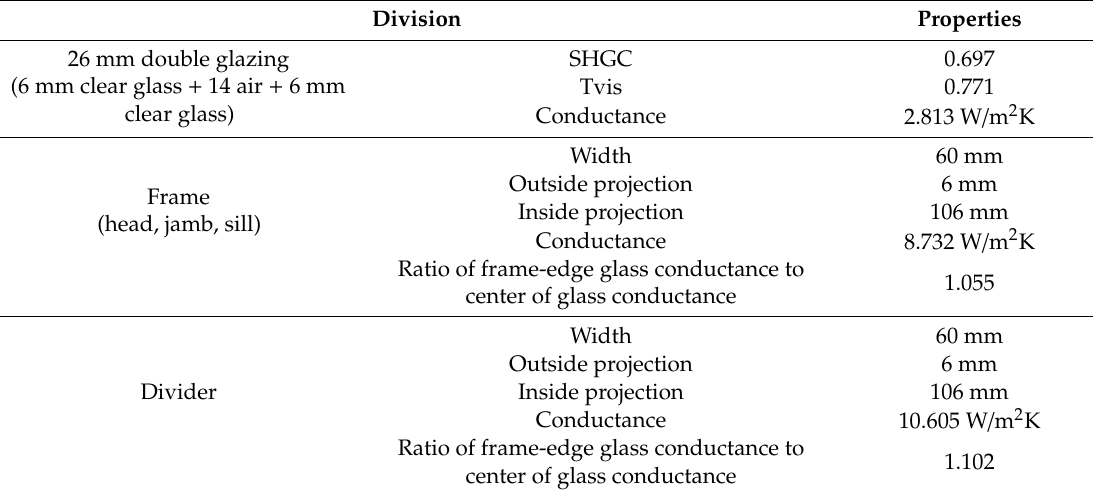
Table 11. Optical and thermal properties of the analysis model’ s old curtain wall.